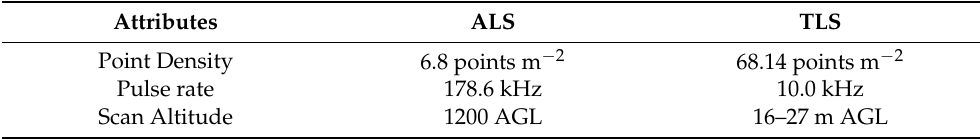
Table 2. ALS and TLS collection